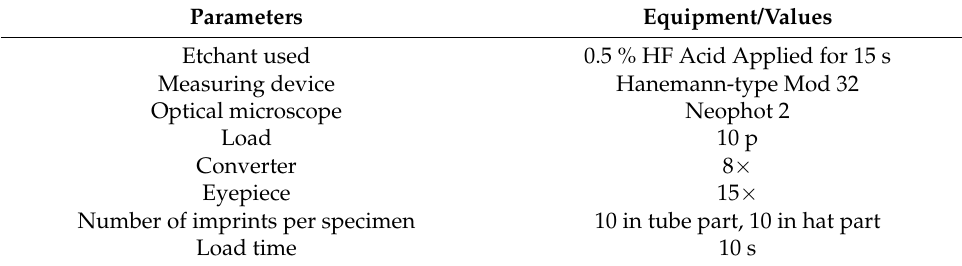
Figure 15. The shapes of Cu inter-metallic from SB 120 variant: ( a ) 3 m.s − 1 ; ( b ) 3.6 m.s − 1 ; ( c ) 4 m.s − 1 ; ( d ) 4 m.s − 1 .